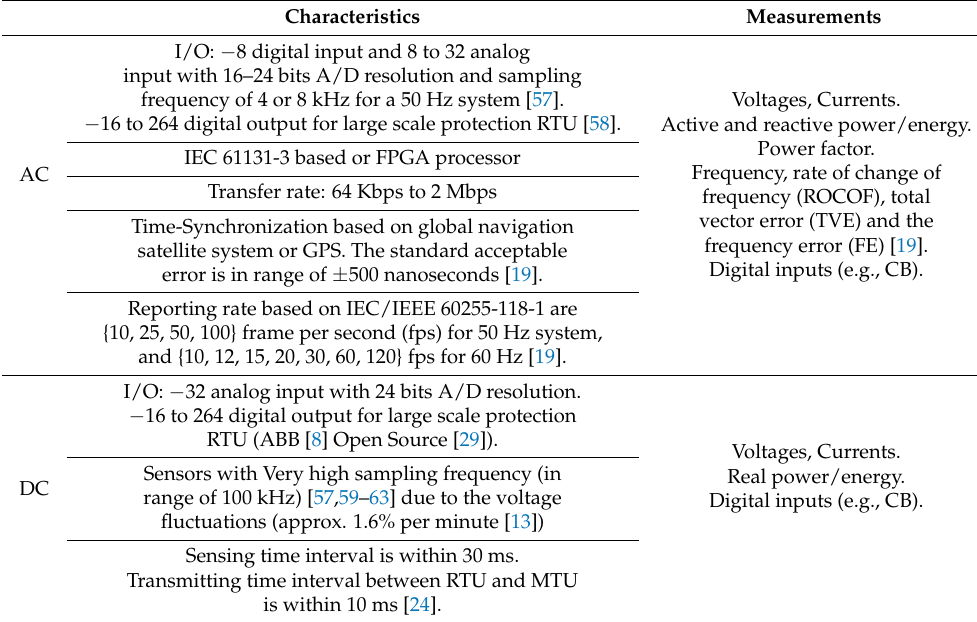
Table 2. AC and DC RTUs characteristics and measurements.